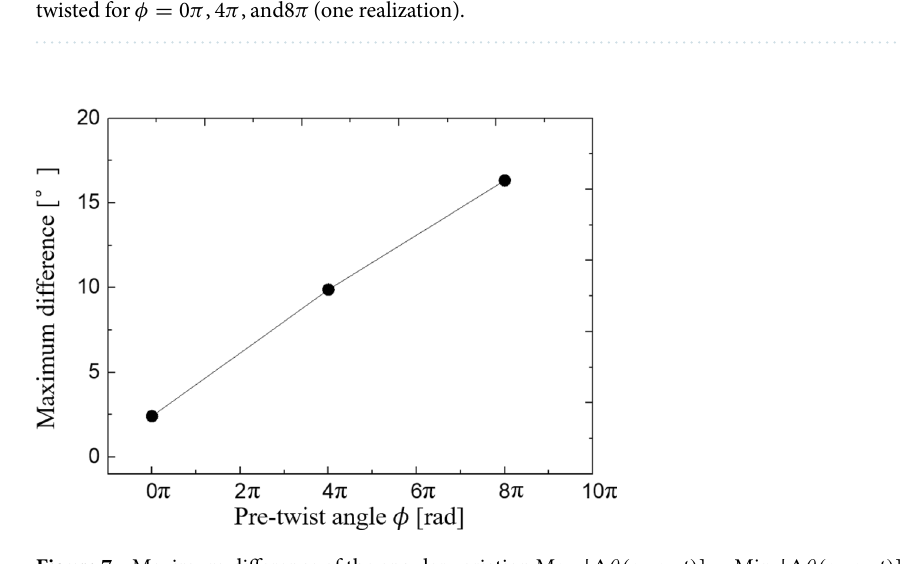
Figure 7. Maximum difference of the angular variation Max t [ �θ( s 1 , s 2 , t ) ] − Min t [ �θ( s 1 , s 2 , t ) ] versus the pre-twist angle φ . Data is the same as that used in Fig.